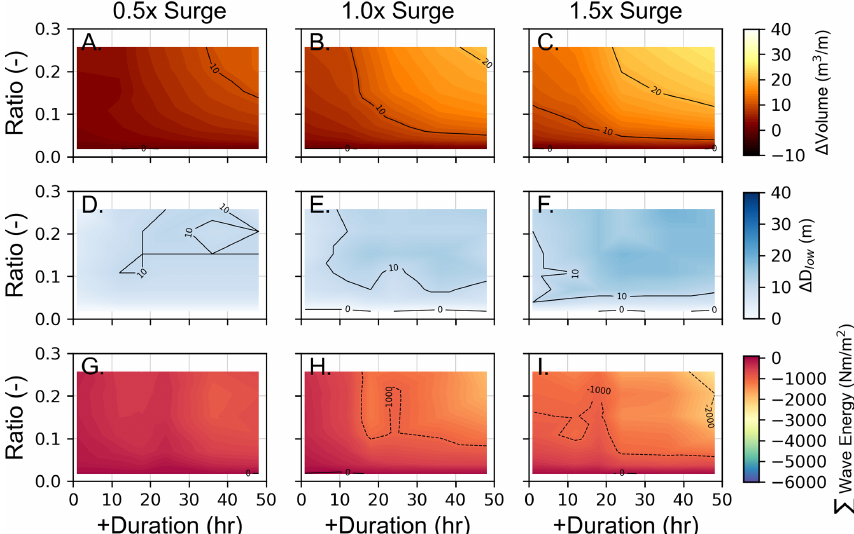
Figure 9. Relative dune erosion and wave impact energy for all crest-aligned simulations as a function of aspect ratio versus storm duration. The values from the equivalent simulations with the dune toes have been subtracted from the crest-aligned simulations to remove the influence from the varying beach widths in the crest-aligned simulations. Each column represents a different storm surge level (increasing left to right). These values represent a comparison relative to the toes aligned simulation (where beach width is controlled for) such that the top row (a–c) shows the amount of volume loss prevented by the wider beach in these simulations, the middle row (d–f) shows the additional dune toe progradation induced by the wider beach width, and the bottom row (g–i) shows the reduction in wave energy reaching the dune due to the wider (and thus lower sloping) beach.